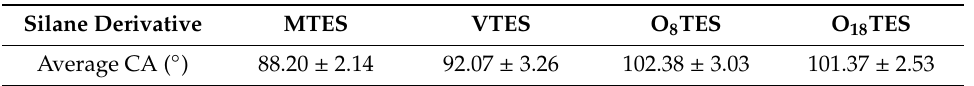
Table 2. The water static contact angle of the films containing only organo-modified silane derivatives.